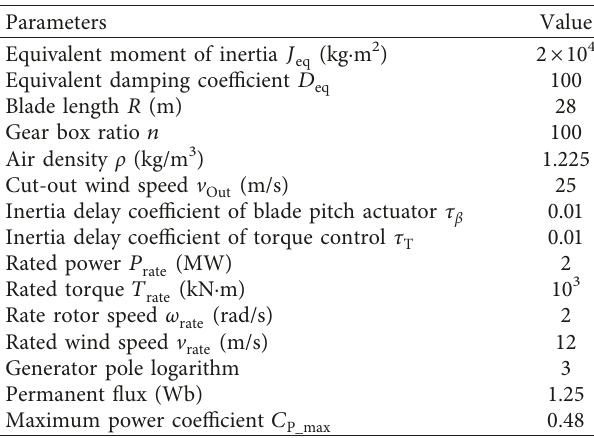
Figure 13: The calculation process of nonlinear gain a (remark: is the precision value of β , and the initial value of Table 1: WECS